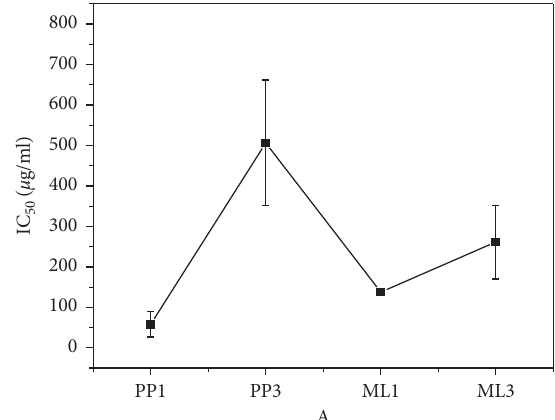
Figure 9: The particle potency to inhibit half of the HeLa cells. Low IC 50 indicates high inhibitory potent.